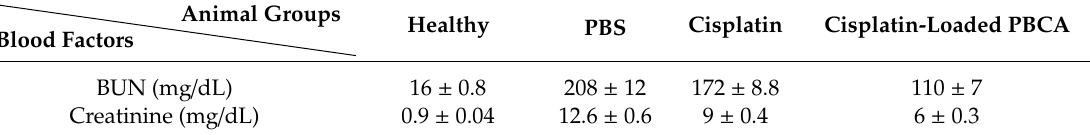
Table 2. Blood concentration of blood urea nitrogen (BUN) and creatinine (mg/dL) in various groups of animals, treated with different formulations (PBS, standard cisplatin, and cisplatin-loaded PBCA nanoformulation) compared to the healthy control group.